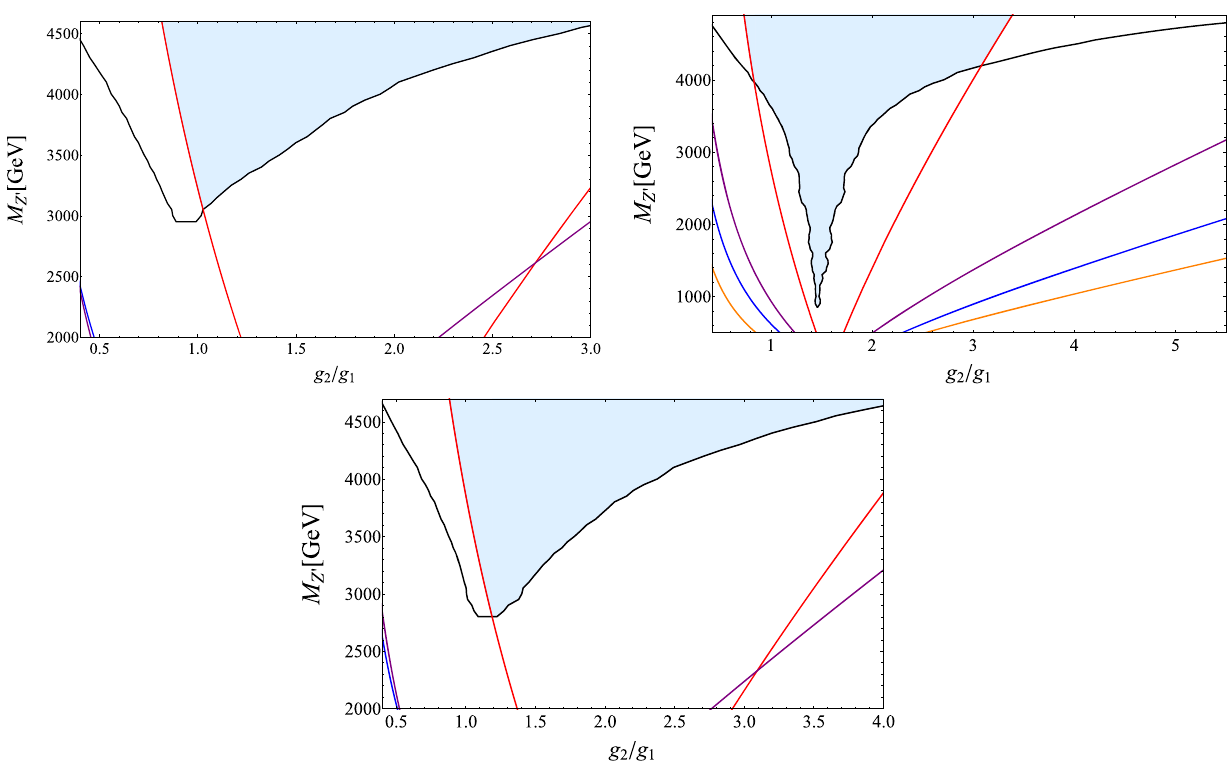
Fig. 2 The allowed parameter region given by the lightblue region ambiguity of the Z boson mass, the LEP data, and weak nuclear charge of Cesium, respectively. The region which is below each of these curves in the g 2 / g 1 − M Z (cid:2) plane for several values of z 1 and z 2 , with (cid:9) M / 2 and m ν (cid:2) = m ν (cid:2) = M / 3. The black, blue, red, m ν (cid:2) is excluded. Top-left panel: z 1 = 1 / 4 and z 2 = 1 / 8. Top-right panel: Z (cid:2) Z (cid:2) 3 R 1 R 2 R z 1 = 1 / 5 and z 2 = 1 / 7. Bottom panel: z 1 = 1 / 5 and z 2 = 1 / purple, and orange curves denote the lower bounds obtained from the current LHC limits, precision measurement of the Z decay width, the